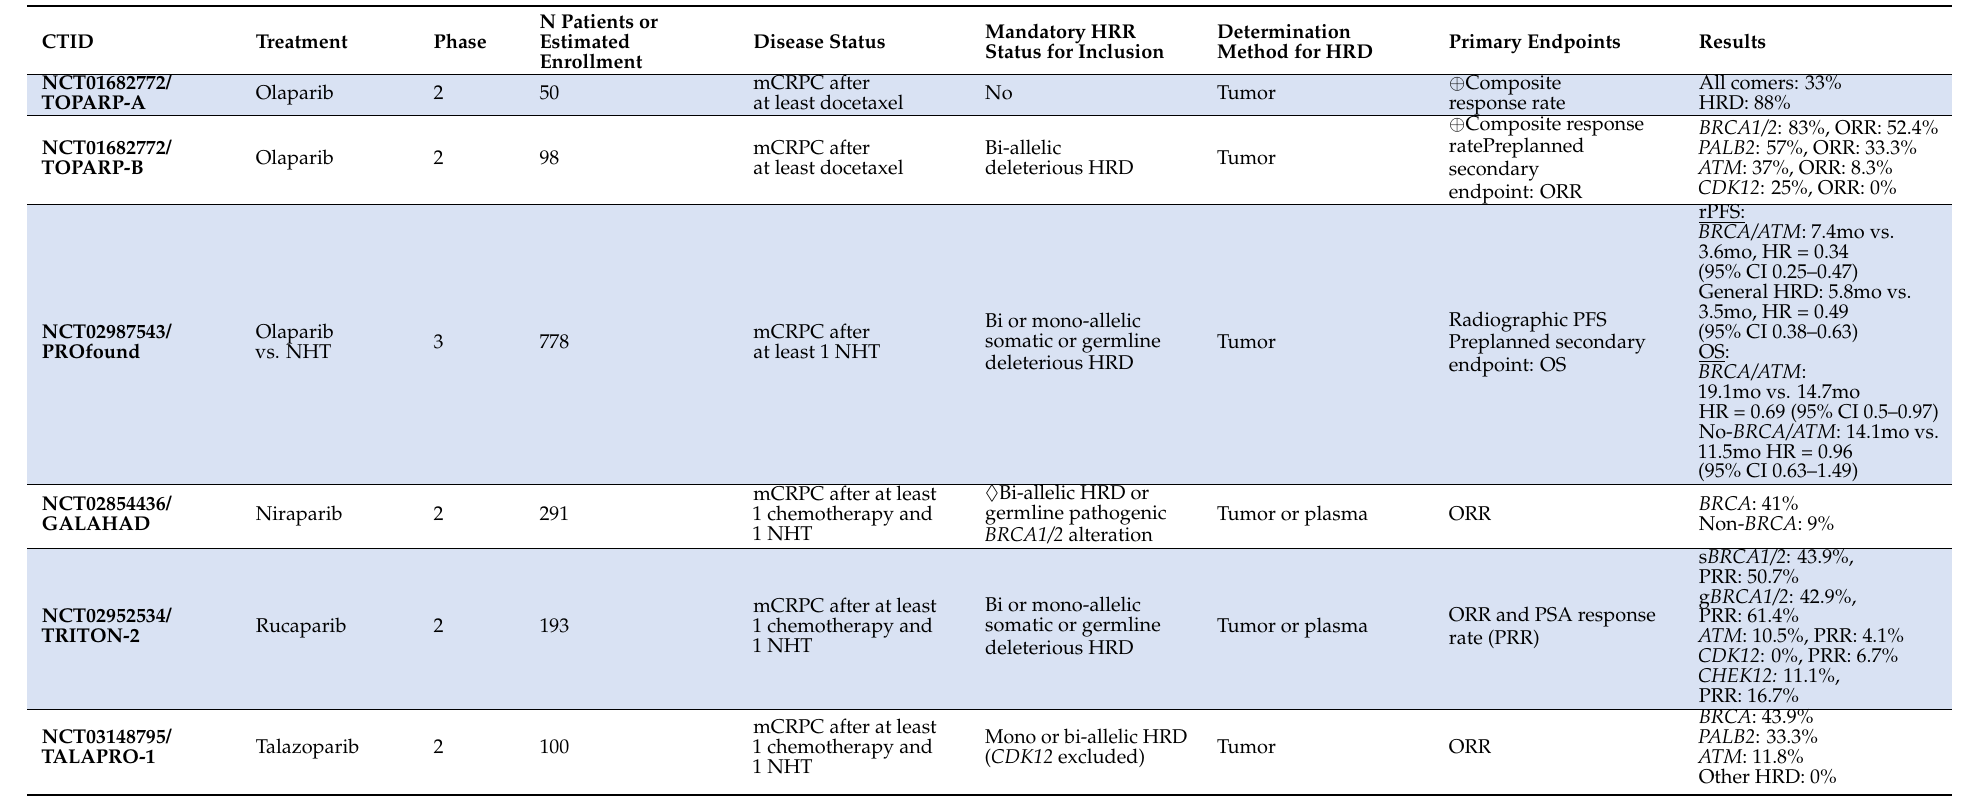
Table 1. Phase II or III trials using PARP inhibitors alone to treat prostate cancers with results. ATM : ataxia telangiectasia mutated, s BRCA : somatic dele- terious mutation of BRCA . g BRCA : germinal deleterious mutation of BRCA . mCRPC: metastatic castration-resistant prostate cancer, NHT: new hormonal therapy. HRR: homologous recombination repair, HRD: homologous repair deficiency, CTID: clinical trial identification, OS: overall survival, PFS: progres- sion free survival, ORR: objective response rate, PSA response rate: decline of more than 50%. ♦ Germline or somatic alteration specified. ⊕ Composite response rate: response according to RECIST or PSA reduction >50%, or reduction of circulating tumor cells to less than 5/7.5 mL of blood confirmed 4 weeks